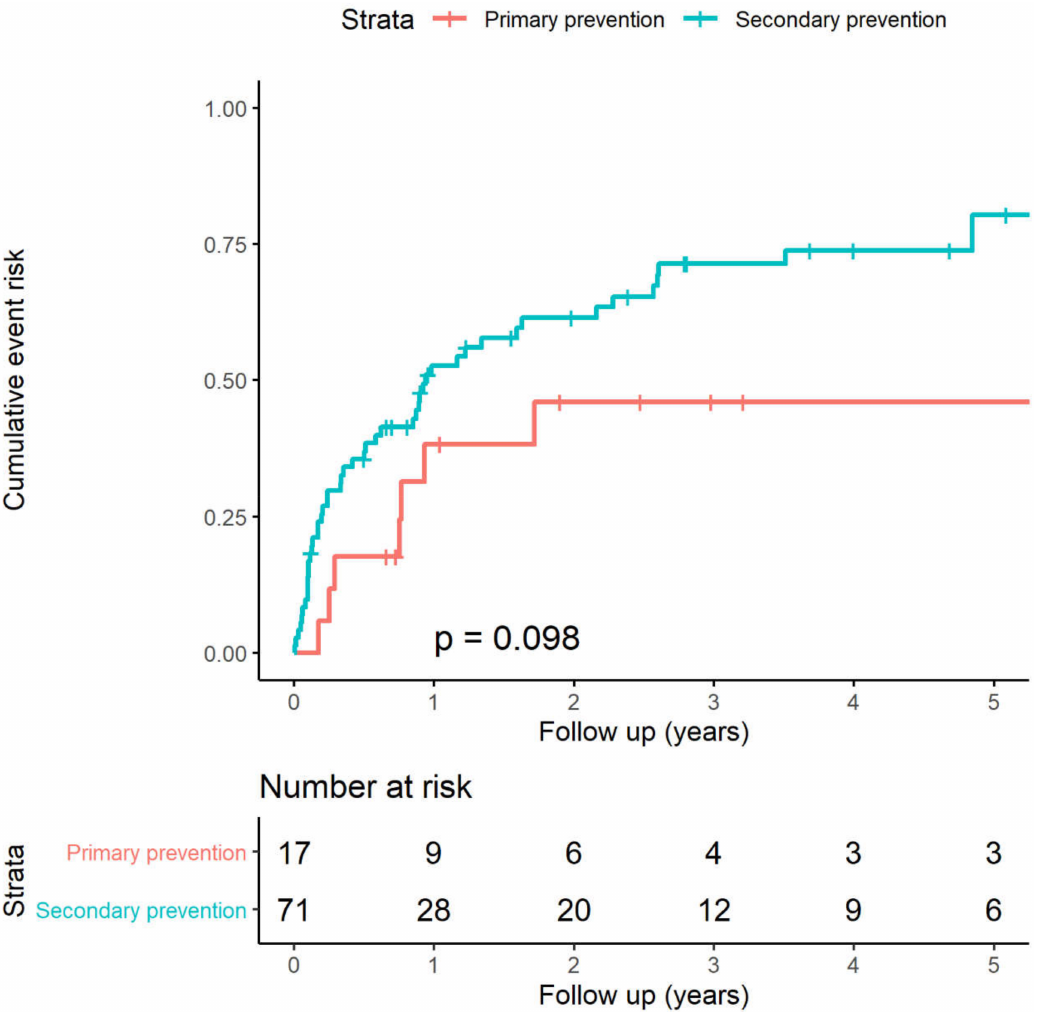
Figure 2. Kaplan–Meier analysis of the appropriate ICD therapy stratified by ICD indications. ICD, implantable cardioverter-defibrillator.